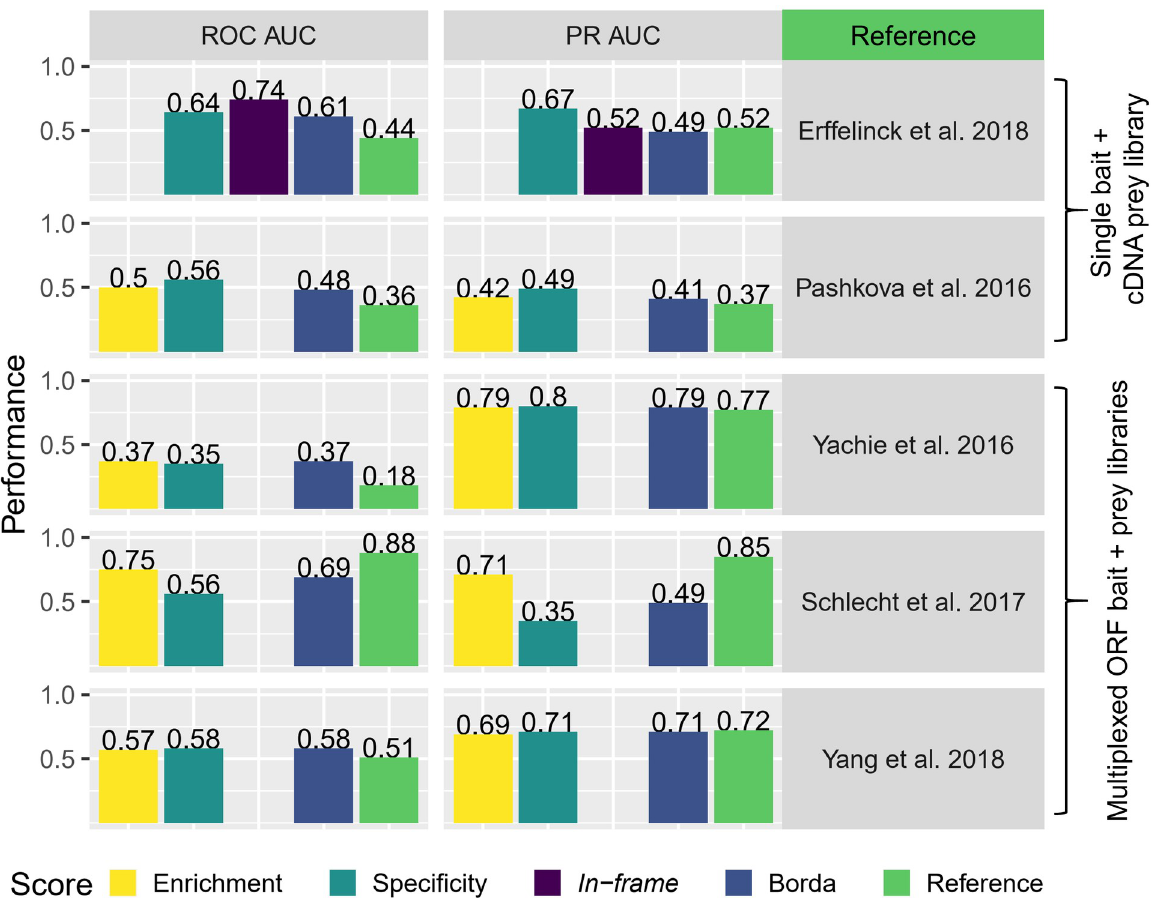
Fig 5. Benchmarking of Y2H-SCORES with published Y2H-NGIS datasets. Receiver Operating Characteristic (ROC) and Precision Recall (PR) AUC values for Y2H-SCORES, the Borda ensemble and the reference scoring method from each study.